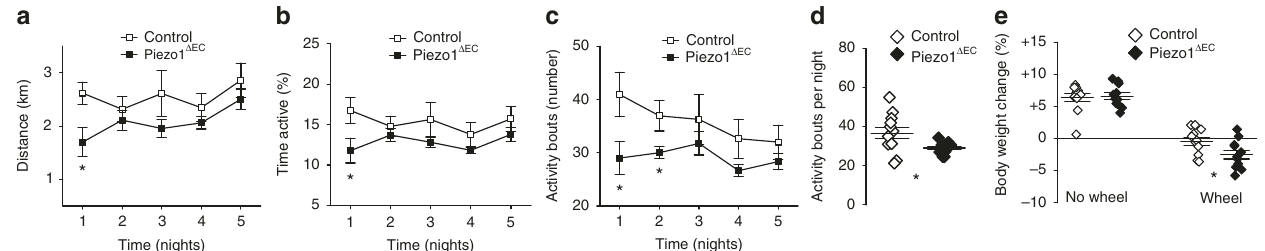
Fig. 7 Physical performance depends on endothelial Piezo1. Voluntary running wheel data for control and Piezo1 Δ EC genotypes from the dark cycle (active period) showing distance run on the wheel a , percentage time for which mice were active on the wheel b and the number of active bouts of exercise c ( n = 12 mice per group). d As for c but summary analysis for all bouts of activity. e For the same mice analysed in a – d , changes in body weight during the 12 days prior to and 7 days after access to the wheel ( n = 12 mice per group). Averaged data are displayed as mean ± s.e.m. Data sets are compared by t -test. Statistical signi fi cance is indicated by * P < 0.05